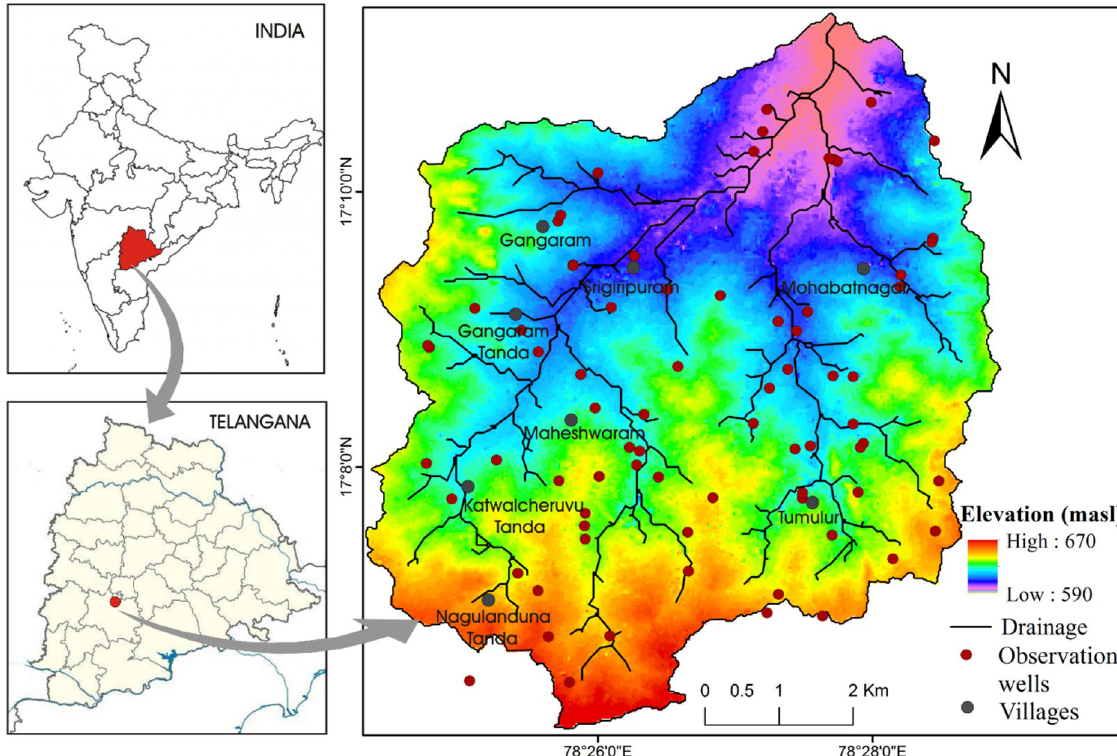
Figure 1. Location map of the study area showing elevation with the drainage